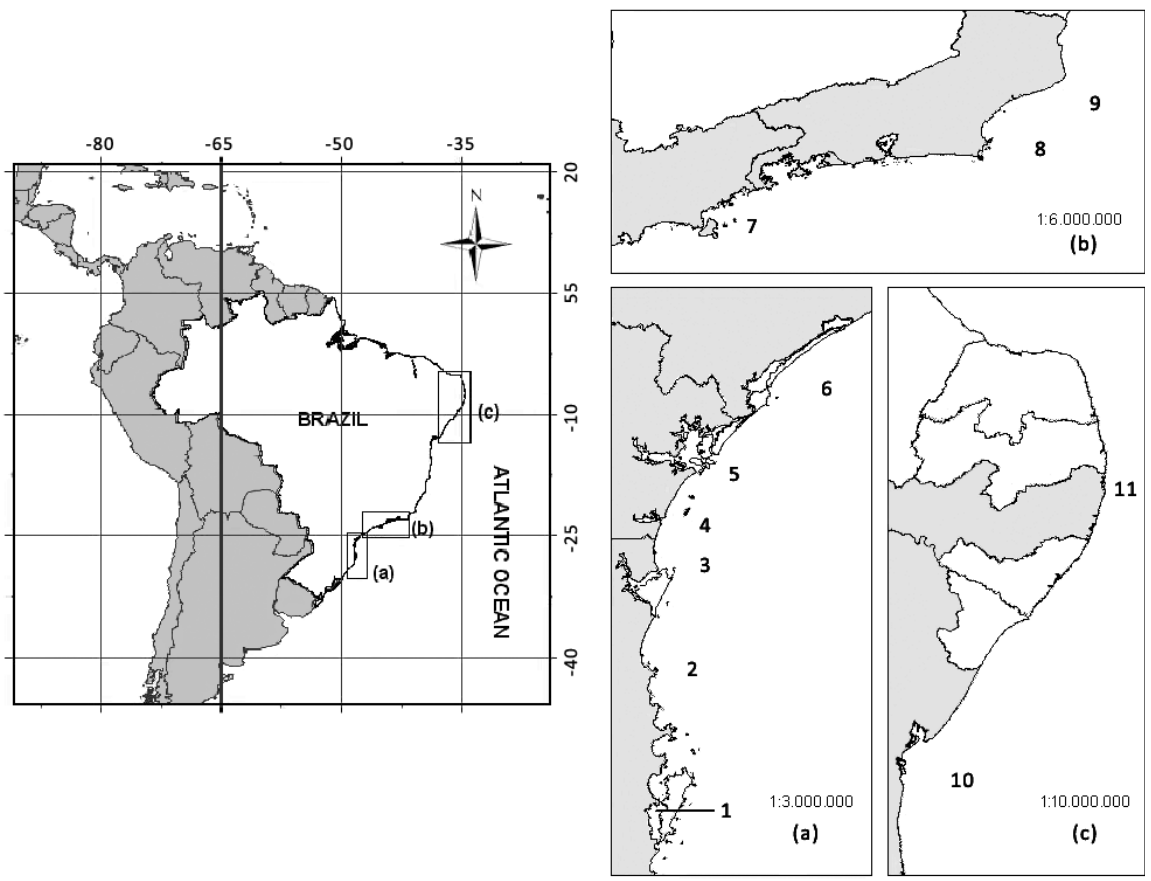
Figure 1 - Study area and positions where Lolliguncula brevis were sampled for morphological and morphometric analysis. Three sectors of the Brazilian coast are presented in detail depicting specific localities and coastline features. Number of females and males collected per sample, locality and latitude-longitude points are indicated Table